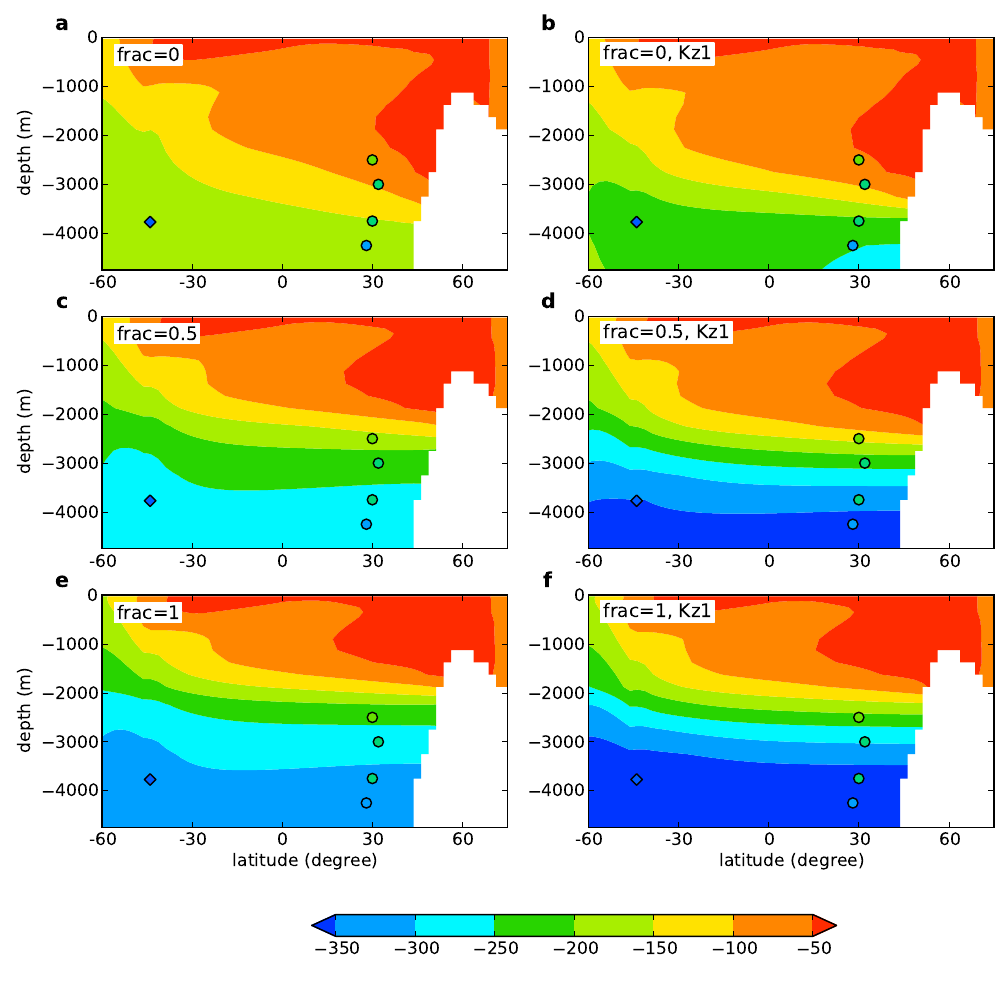
14 C − 1 ) ). The dots represent the LGM data DIC